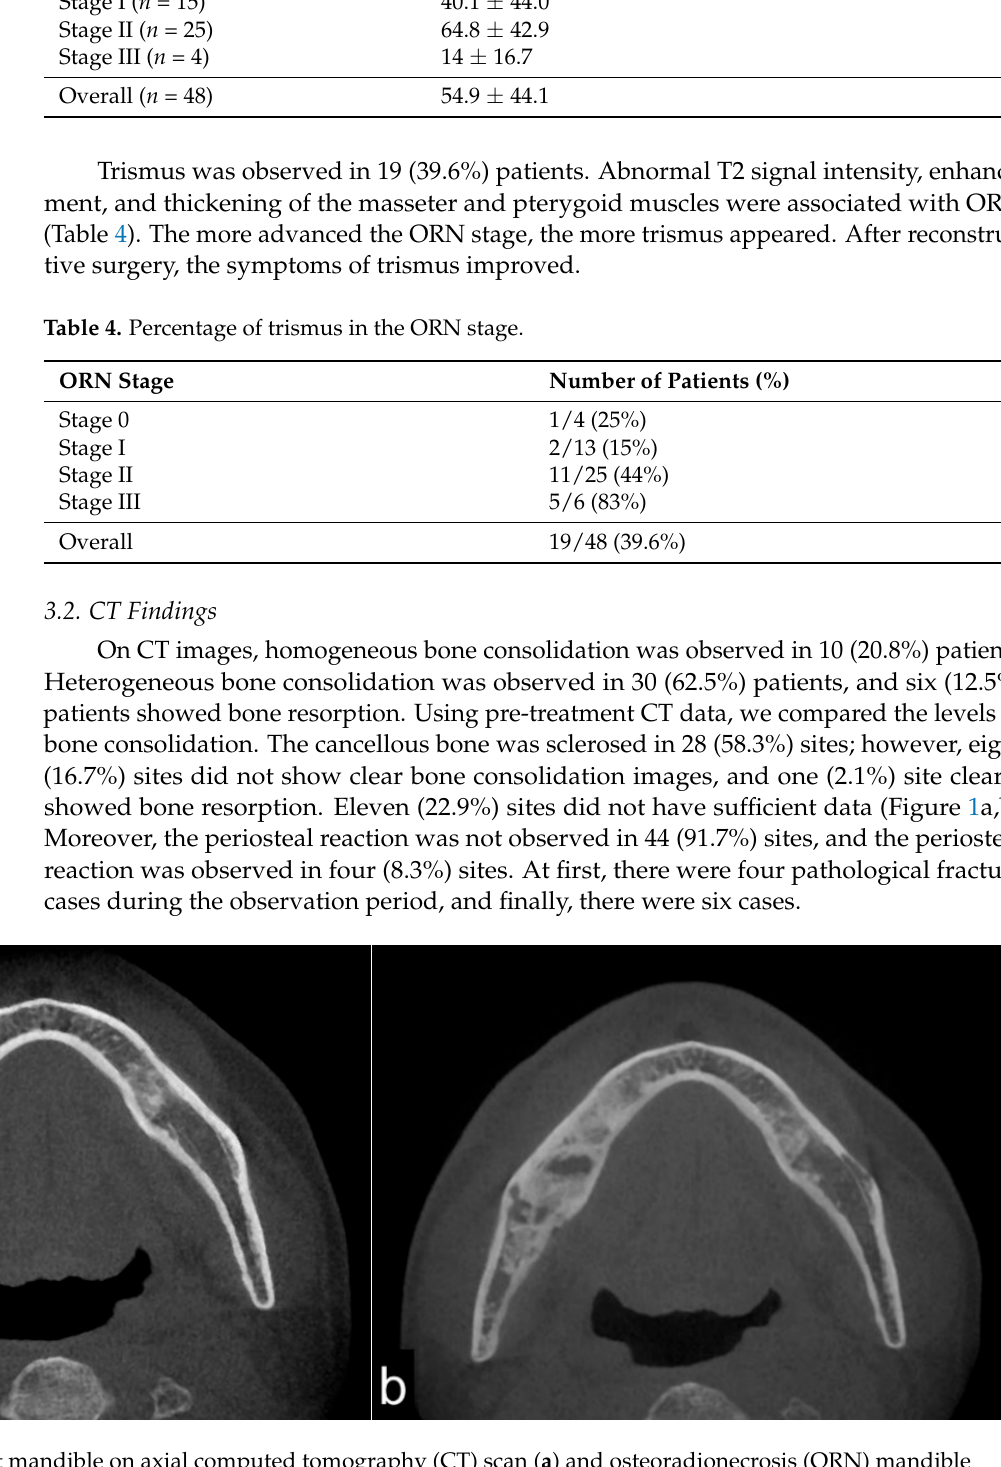
Figure 1. Pre-treatment mandible on axial computed tomography (CT) scan ( a ) and osteoradionecrosis (ORN) mandible on axial CT scan ( b ). The image shows bony sclerotic changes with ORN ( b ) involving the right mandible compared to the pre-treatment mandible in the same lesion without periosteum reaction (arrowhead). These reactions may have been induced by irradiation.